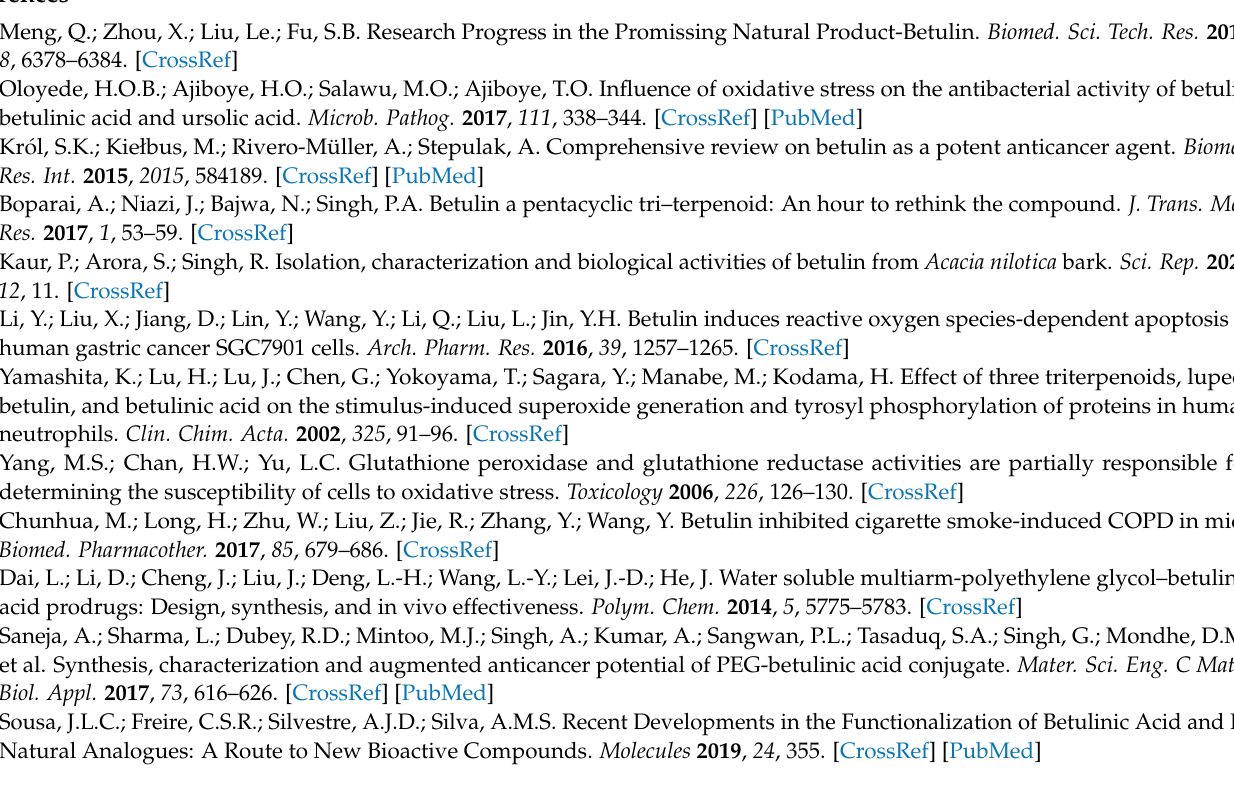
RAFT polymerization control. Table S1: Data from the HPL chromatograms for RAFT polymerization control. Figure S2: Fluorescence spectra of pyrene (2 × 10 –7 M) at different concentrations of Bet-1 (a) and Bet-2 (b) co-polymers in water at 25 ◦ C. Figure S3: FTIR spectrum of maltodextrin modified using cerium oxide nanoparticles. Figure S4: Oxidation of ascorbic acid in an acidic medium using cytochrome c . Table S2: Dynamics of cytochrome c reduction using ascorbic acid according to electronic absorption